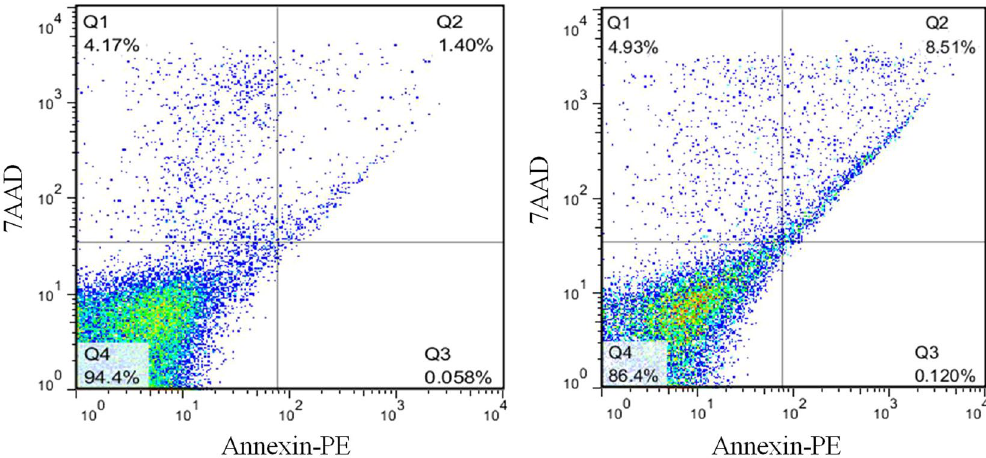
Figure 10. Contour density plots for determination of fractions of early apoptotic, late apoptotic, and necrotic cell death of live WBC cells, respectively. Panel A shows the untreated cells as control, while ( B )displays the treated cells with LD 50 concentrations of ASNPs, for 24 h. The cell necrosis and apoptosis were measured by using 7-AAD and Annexin-V dyes in flow cytometry based